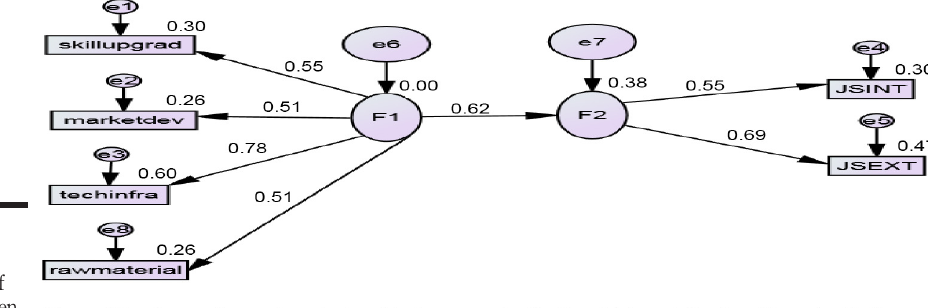
Figure 2. Structural model of relationship